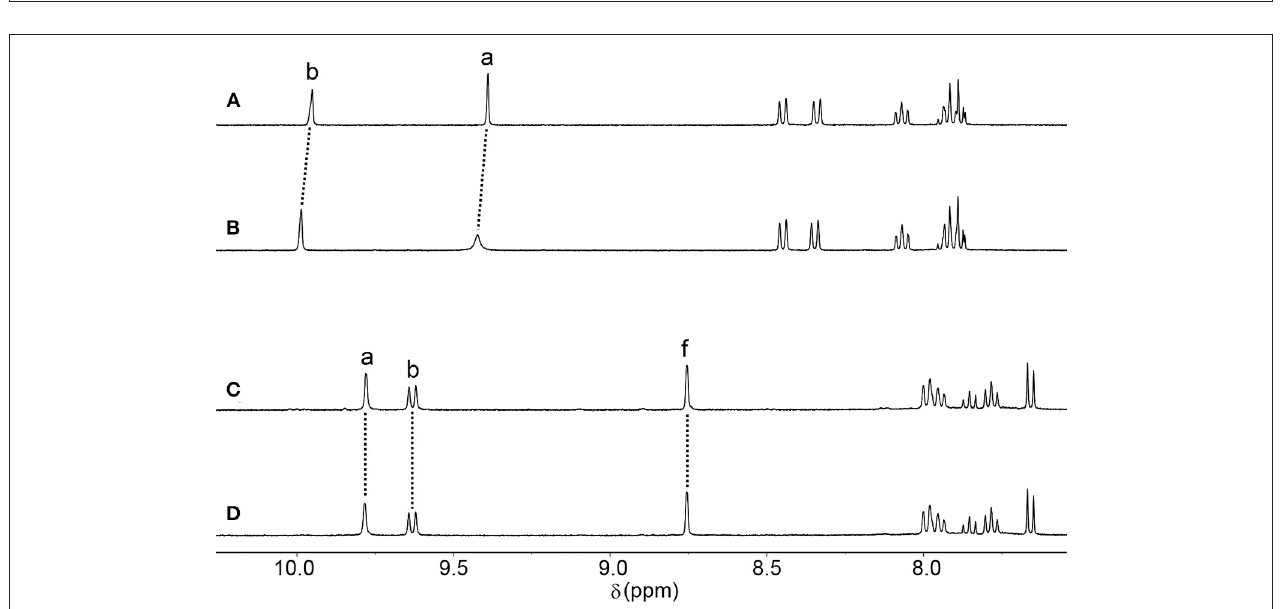
FIGURE 4 | Partial 1 H NMR (500 MHz, CD 3 CN, 298K) stacked plot of (A) C iq (B) C iq + cisplatin (10 eq.) (C) C q , and (D) C q + cisplatin (10 eq.).